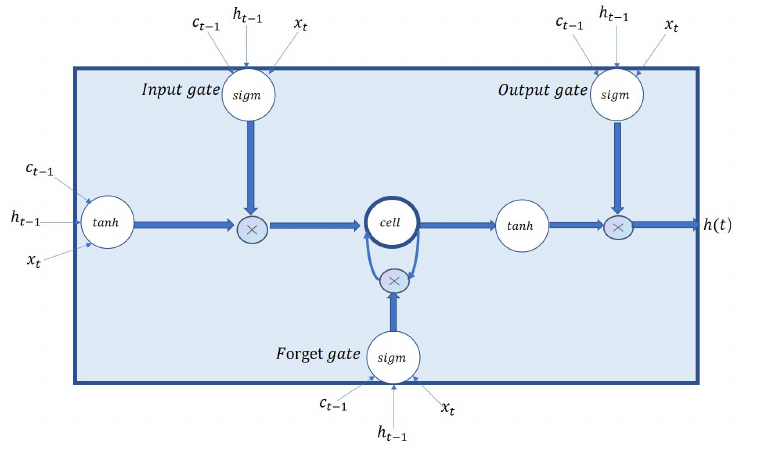
Figure 1. The structure of